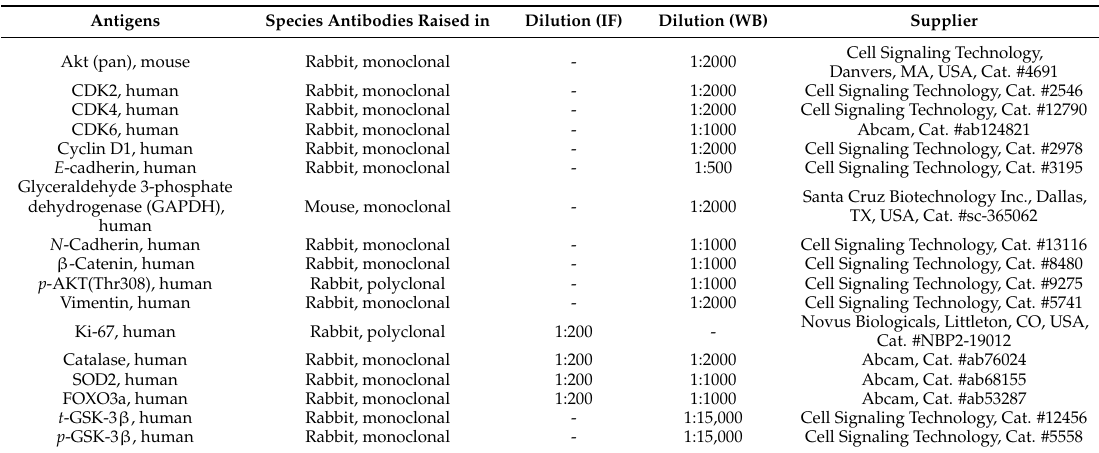
Table 1. List of primary antibodies.